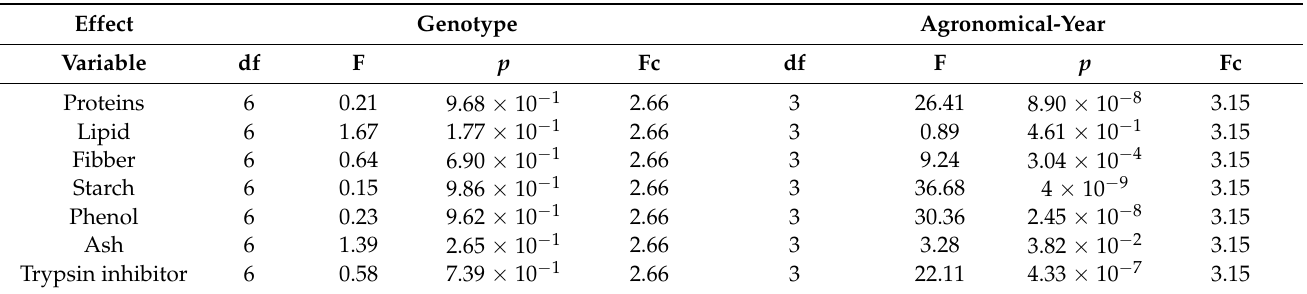
Table 5. Fisher values and probability error for the nutritional and antinutritional variables of the seven locally adapted bean genotypes in four cultivation conditions.